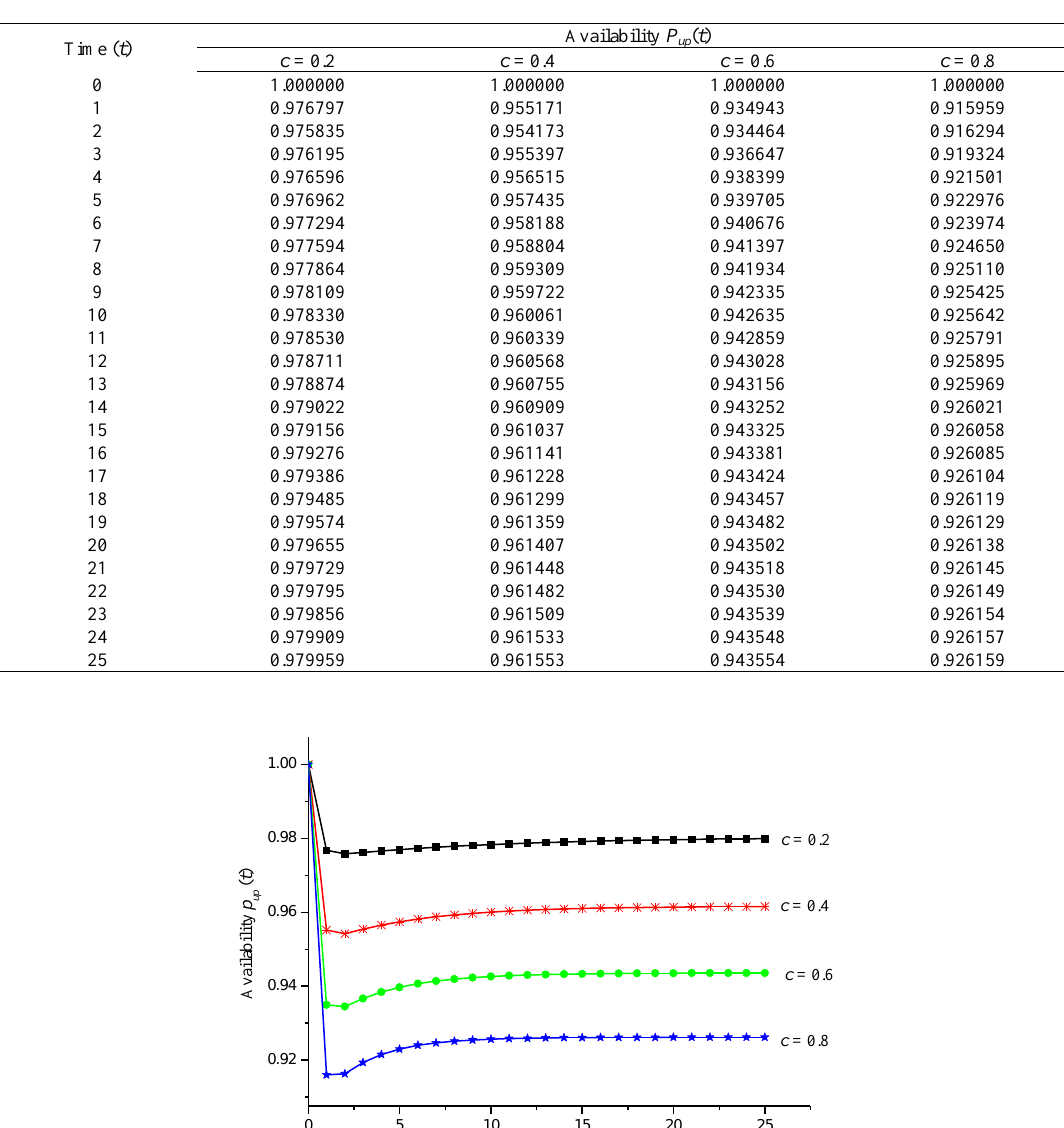
Table 5. Availability of the system with copula at different values of coverage factor.